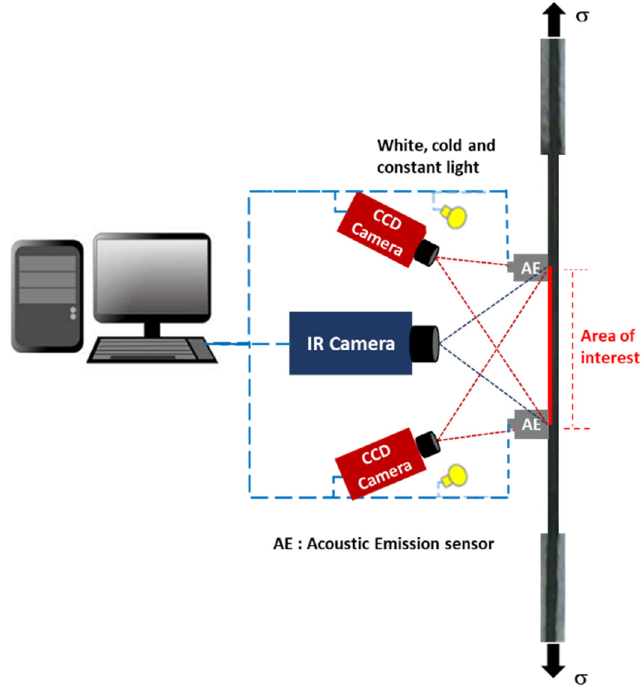
Figure 9. Example of a hybrid non-destructive testing system. Implementation of acoustic emis- sion/ultrasonic guided waves, digital image correlation, and passive infrared thermography.